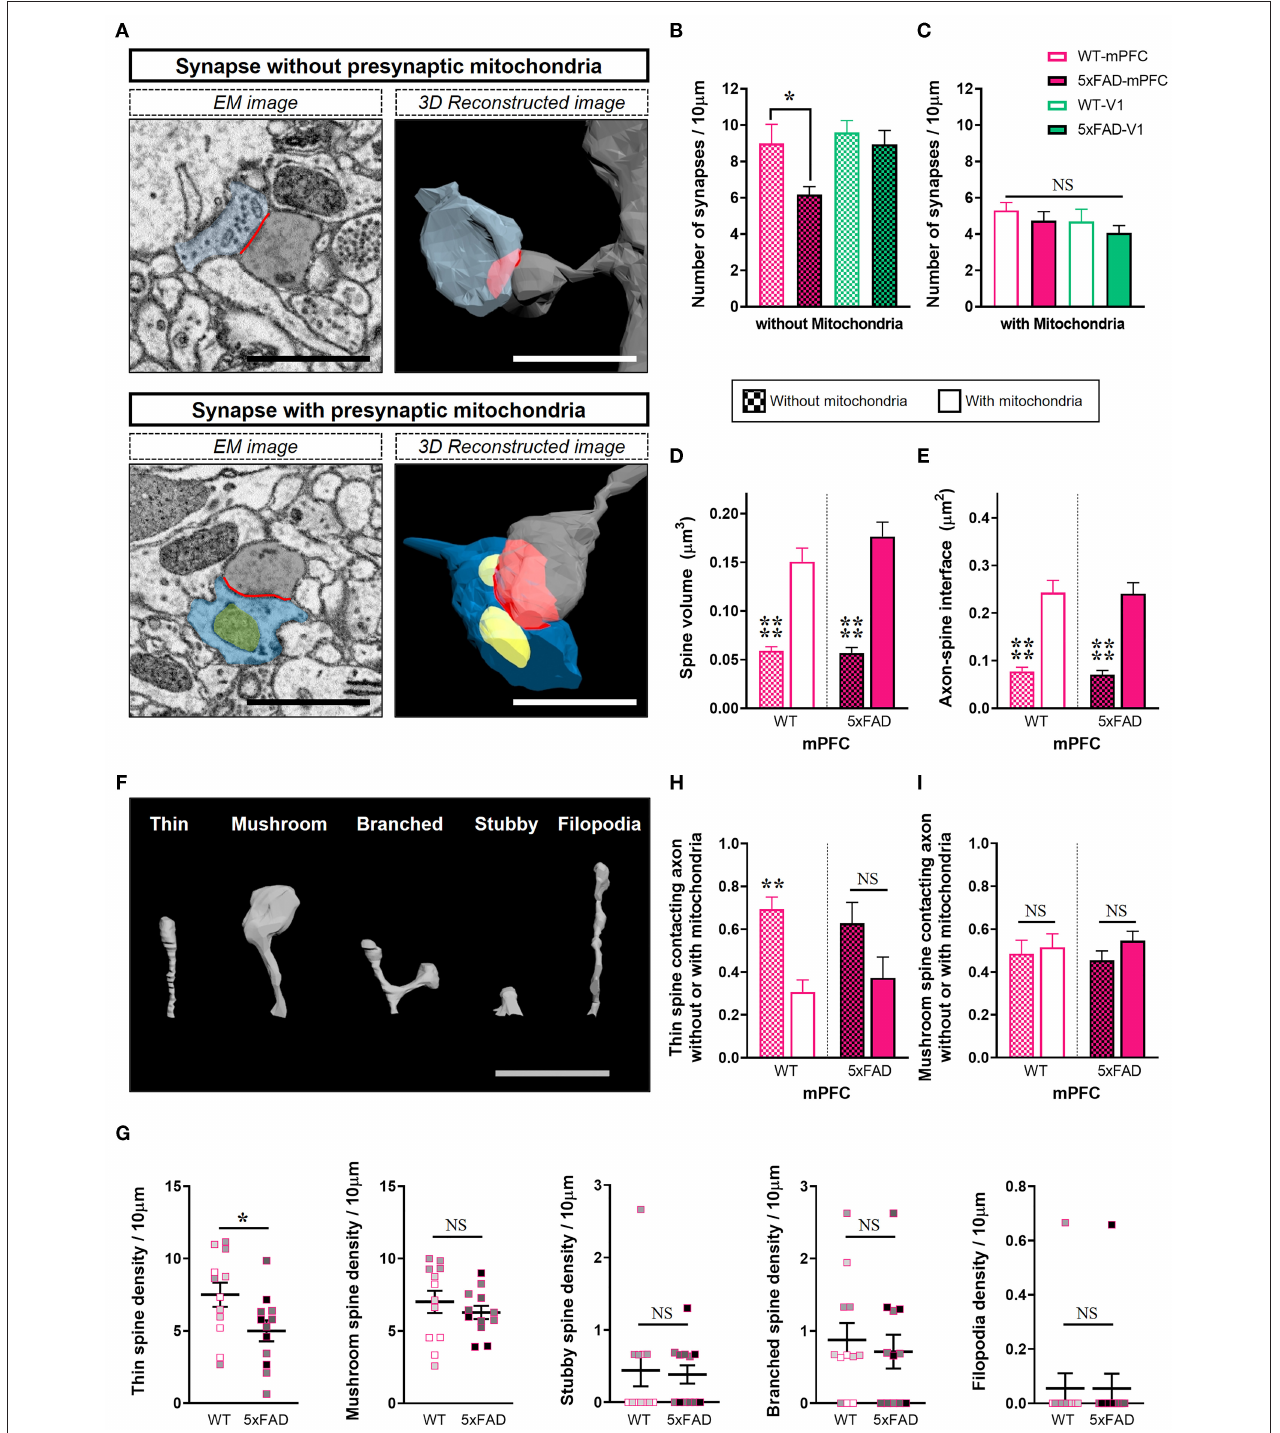
FIGURE 3 | Selective loss of synapses lacking presynaptic mitochondria in the 5xFAD mPFC. (A) Representative EM (left) and 3D reconstructed (right) images of synapses either containing or lacking presynaptic mitochondria. Blue, presynaptic bouton; yellow, mitochondria; gray, dendritic spine; red, axon-spine interface (ASI). Scale bar, 1 µ m. (B,C) Quantification of densities of synapses without (B) or with (C) presynaptic mitochondria in the mPFC and V1 of WT and 5xFAD mice ( n = 9–12 dendrites per group). * P < 0.05; two-way ANOVA with post-hoc Tukey test. (D,E) Quantification of average spine volume (D) and ASI area (E) of synapses with or without presynaptic mitochondria ( n = 87–95 mitochondria-containing synapses; 100–154 mitochondria-lacking synapses). **** P < 0.0001; Kruskal–Wallis test